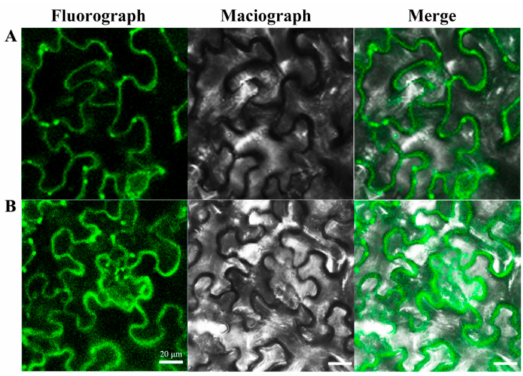
Figure 12. Subcellular localization of PbRBOHA-GFP and PbRBOHD-GFP. ( A ) Subcellular localization of PbRBOHA-GFP. ( B ) Subcellular localization of